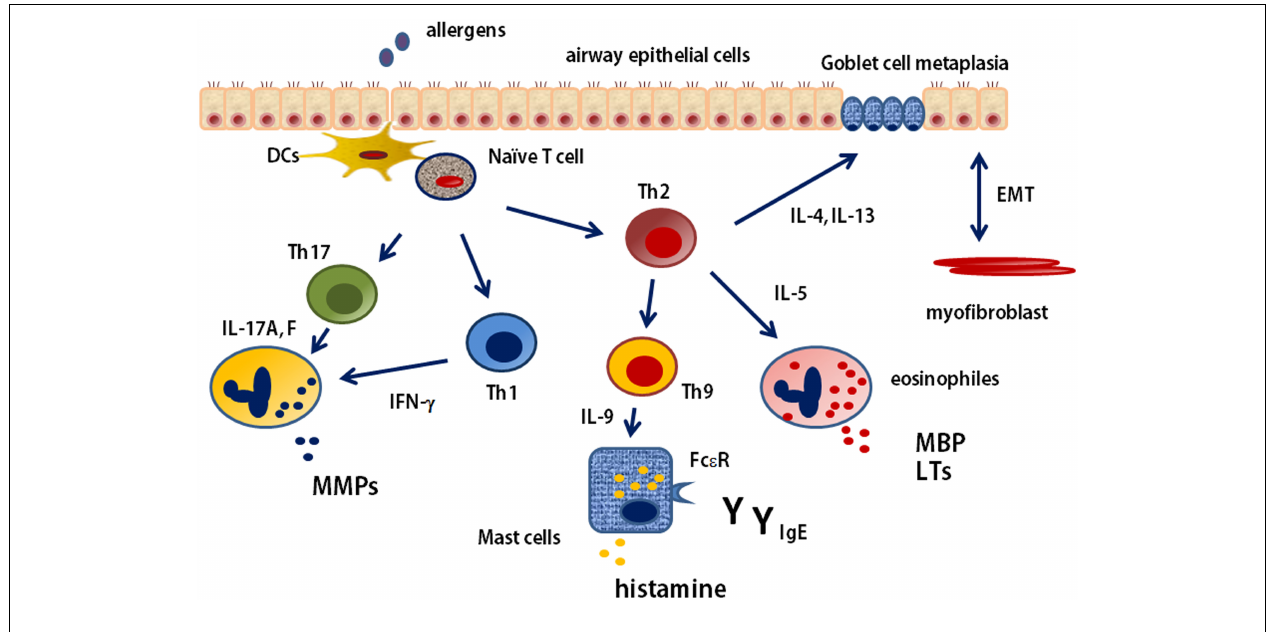
mast cells by IL-9. Naïve T cell is also differentiated to Th1 or Th17 cells depending on the existence of cytokines in the microenvironment. Th1 cell and Th17 cell stimulate and induce neutrophilic inflammation. EMT, epithelial-mesenchymal-myofibroblast transition; MMP, matrix metalloproteinase; MBP, major basic protein; LT,